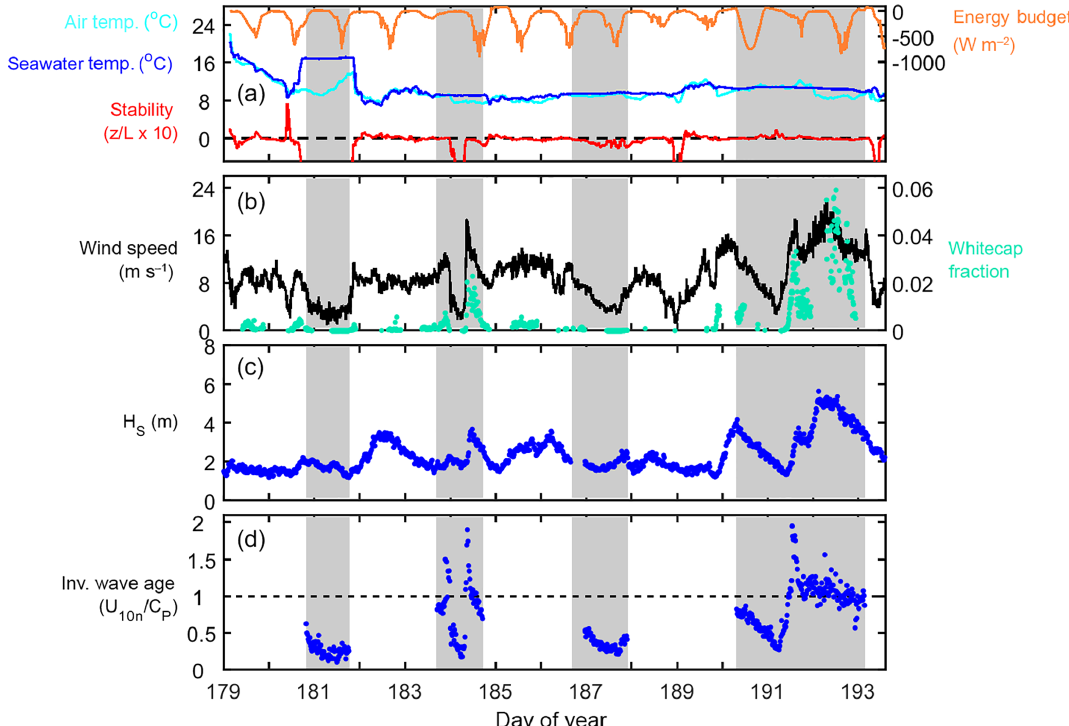
Figure 1. Time series of 10min averaged data collected during the Knorr_11 cruise. Dashed black line in panel (a) indicates neutral at- mospheric stability ( z/L = 0). Grey shaded regions represent intervals when the ship occupied stations ST181, ST184, ST187, and ST191. Measured wave properties (see Bell et al., 2013) are presented in panels (c) and (d) : significant wave height H s (c) and inverse wave age (d) . U 10 n / C p ≥ 1 represent younger seas and U 10 n / C p <1 represent older seas.